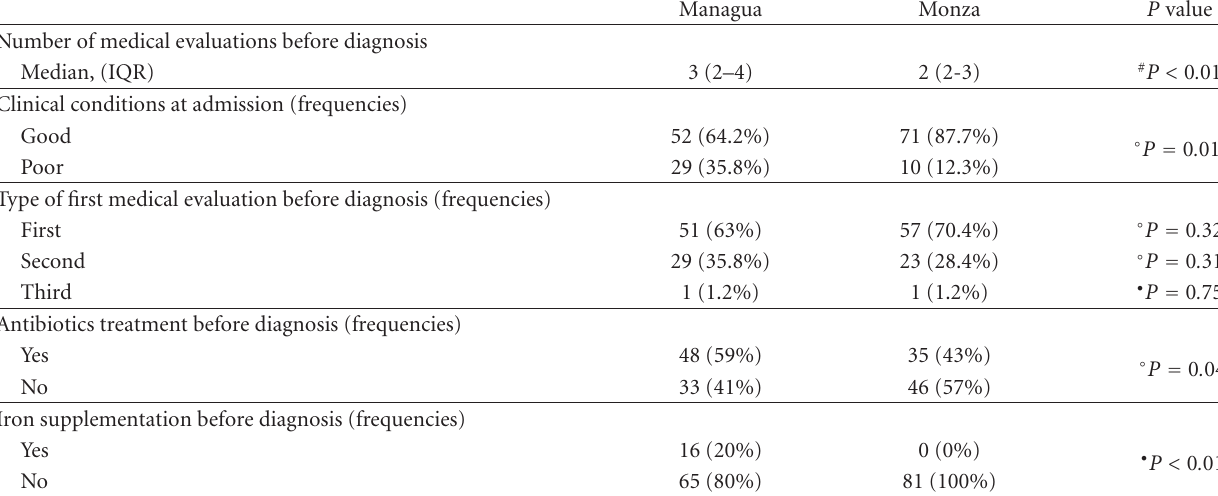
Table 2: Medical assessments performed before diagnosing leukemia and clinical condition at the diagnosis. Managua